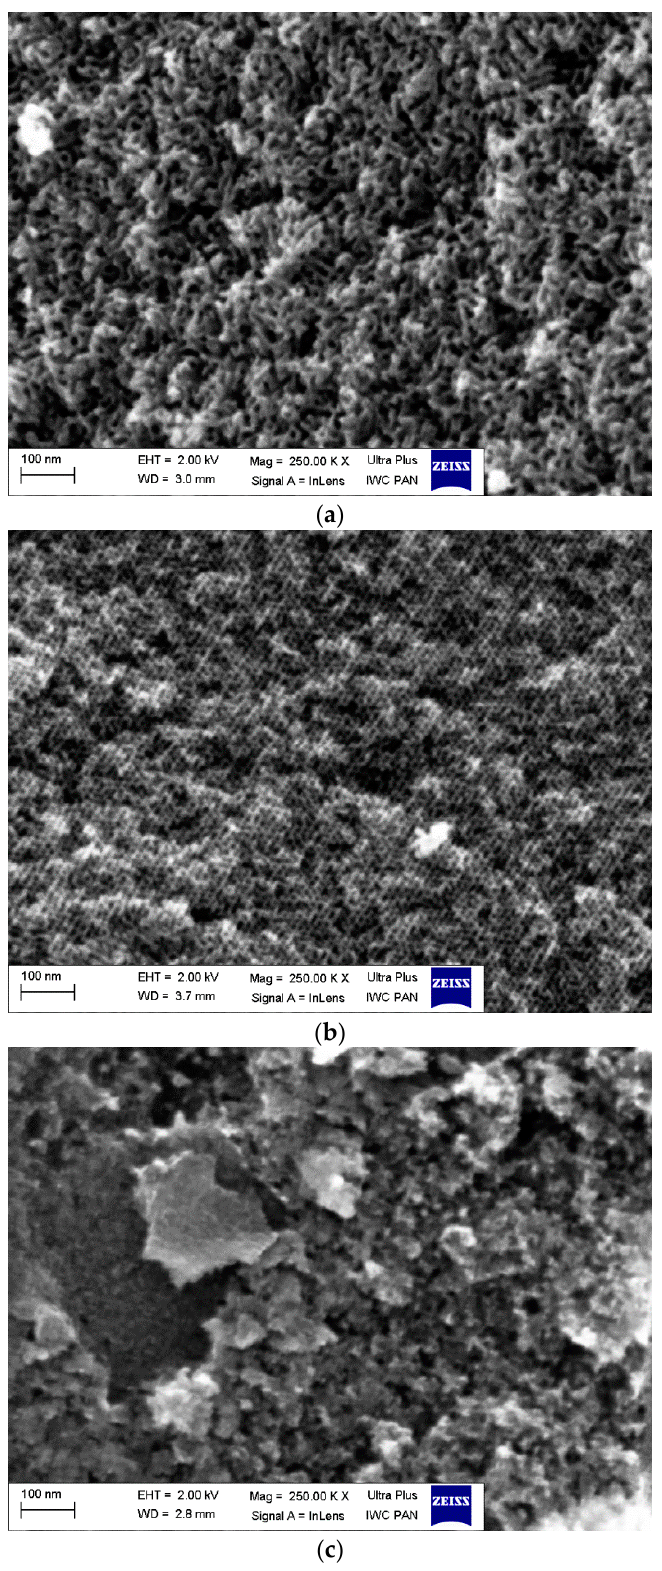
Figure 4. SEM images of samples: ST-A-P ( a ), ST-A-P-CO 2 ( b ), WG-15 ( c